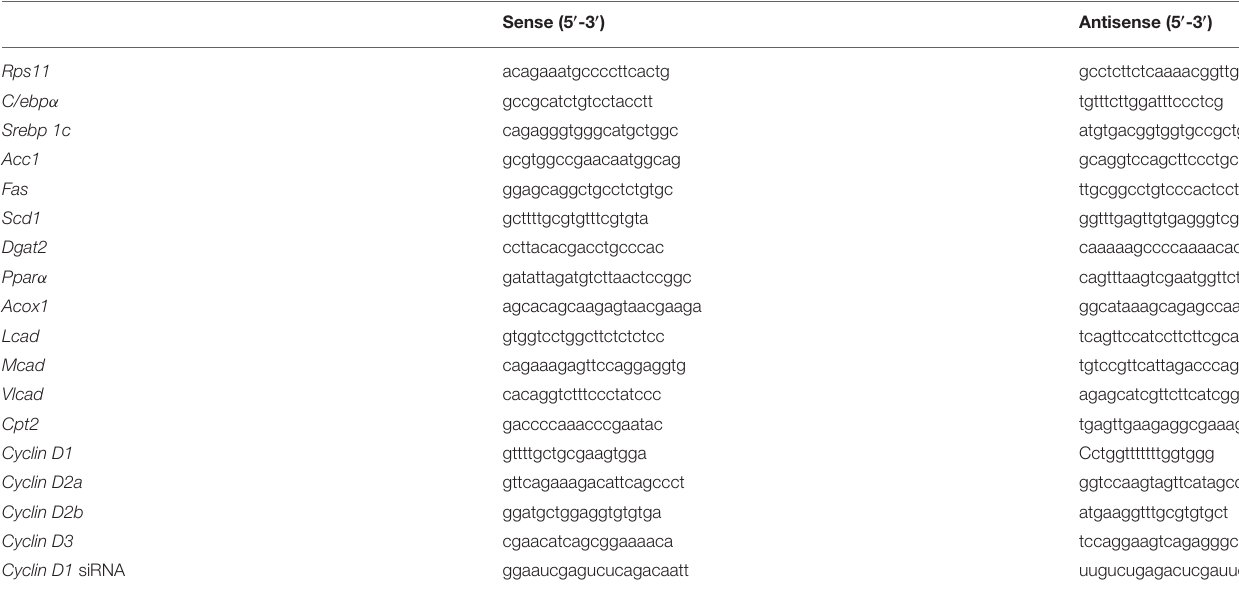
TABLE 3 | Quantitative PCR primers and si RNA